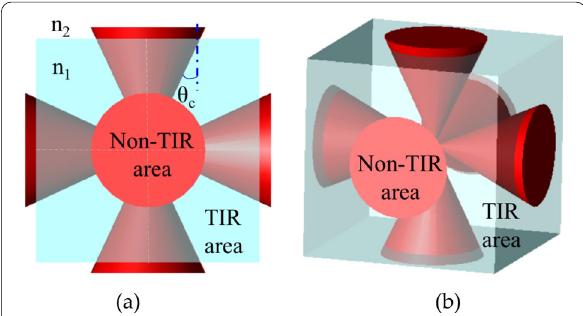
Fig. 1 Total reflection inside the light guide layer. a Flat diagrammatic sketch and b three dimensional diagrammatic sketch